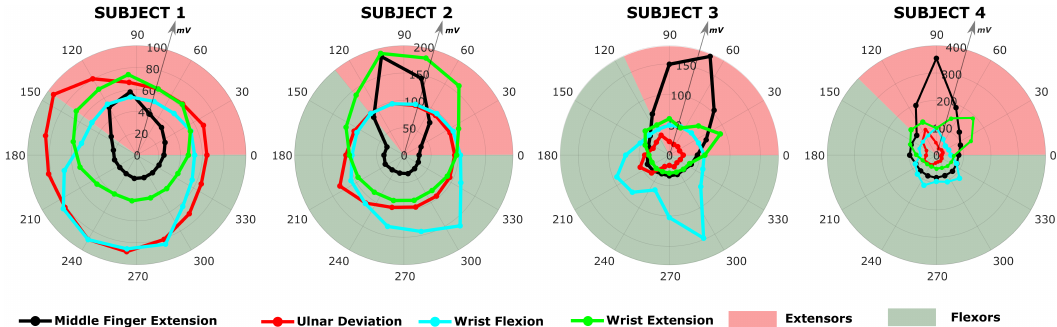
Figure 7. sEMG RMS profile for the four considered tasks at 50% MVC for all the subjects. Each isometric task profile is represented with a different color with a circle indicating the local value measured on the electrode. The electrodes are assumed to be equally distributed around the circumference of the cross section of the forearm. The posterior and anterior side, corresponding to the sectors where extensor and flexors muscles are located, are represented with different background